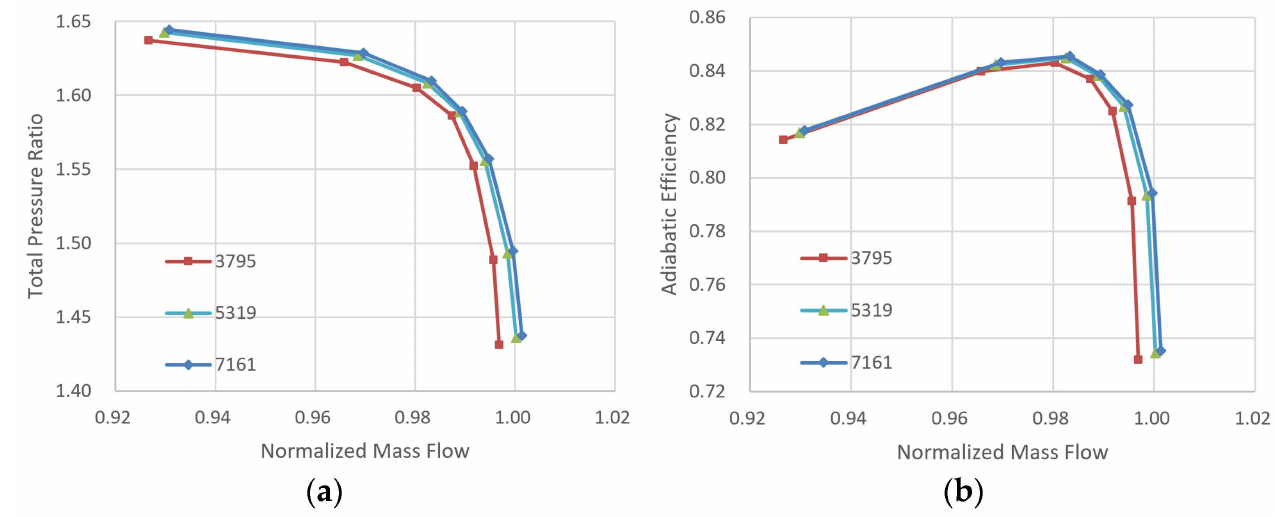
Figure 10. Comparison of the 11D compressor performance parameters obtained from different grids with the same CAM scheme: ( a ) mass flow versus total pressure ratio; ( b ) mass flow versus adiabatic